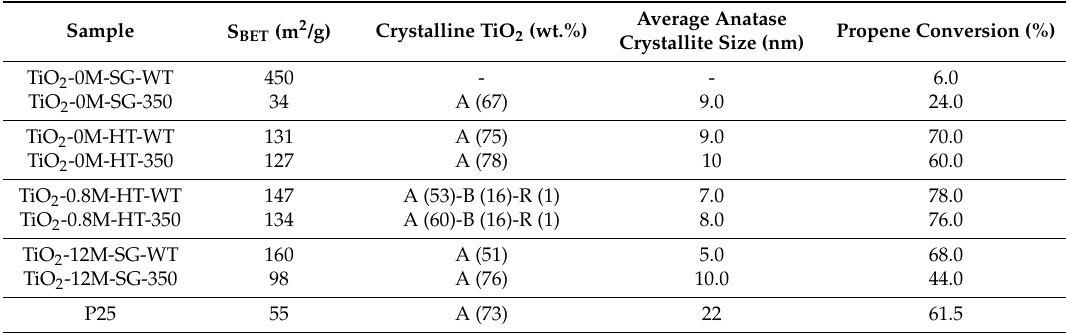
Table 3. Physico-chemical properties and propene conversions for TiO 2 -0M-SG, TiO 2